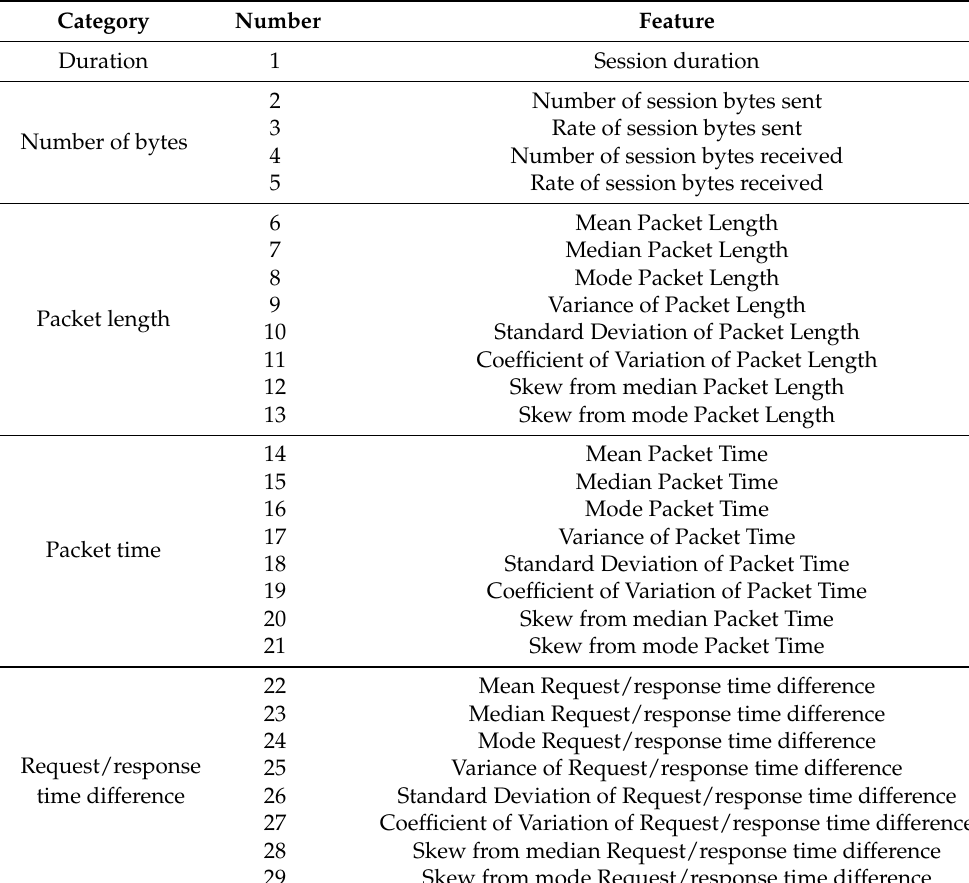
Table 2. Session statistical